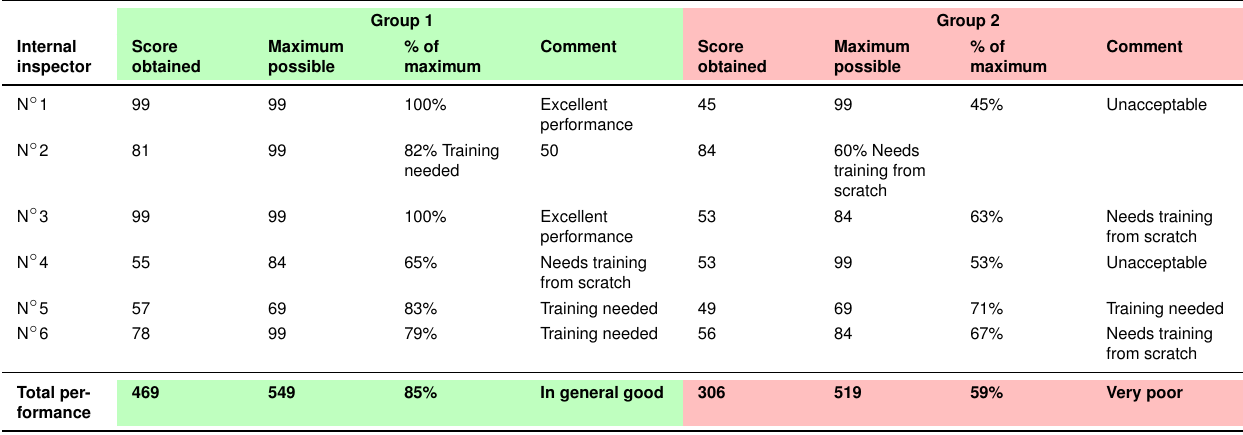
Table 7. Summarising the scores from different witness audits for assessing the overall performance of internal inspectors. In these fictitious examples for two groups, six from a total of 10 internal inspectors have been witnessed. The maximum possible score (third column) differs from case to case, because not all questions are applicable to all farms (see Table 6, third